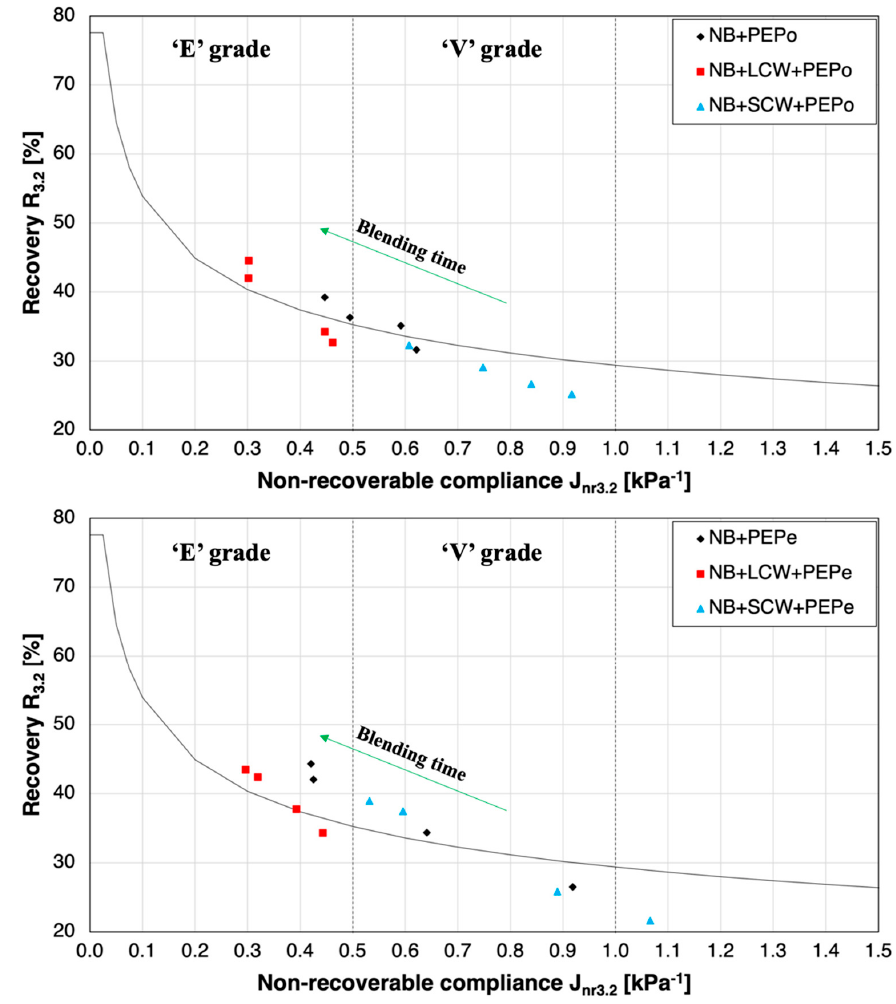
Figure 7. Effect of the mixing time on the rutting performance of all blends.